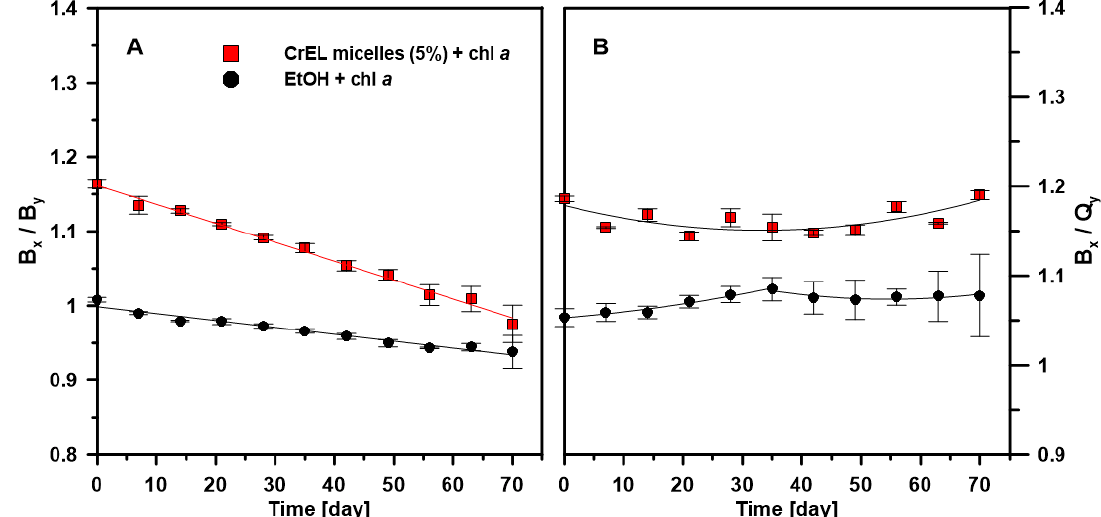
Figure 3. Stability of chl a in the CrEL nano-micelles over time. Stability was expressed as B x /B y (panel A ) and B x /Q y (panel B ) ratios varying with time (70 days). Chl a at the molar concentration of 10 − 5 M was dissolved in the 5% Cremophor EL nano-emulsion (CrEL micelles (5%) + chl a ; red squares) or, for comparison, in 96% ethanol (EtOH, black circles). The samples were stored in the dark for 70 days. The experiment was repeated three times (biological replicates). The presented mean values ±SD are obtained on the basis of the absorbance spectra.